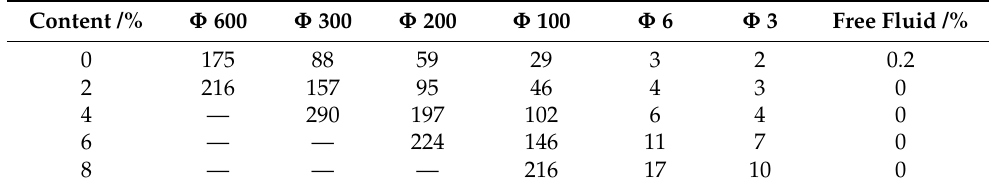
Table 3. Rheological properties and free fluids of cement